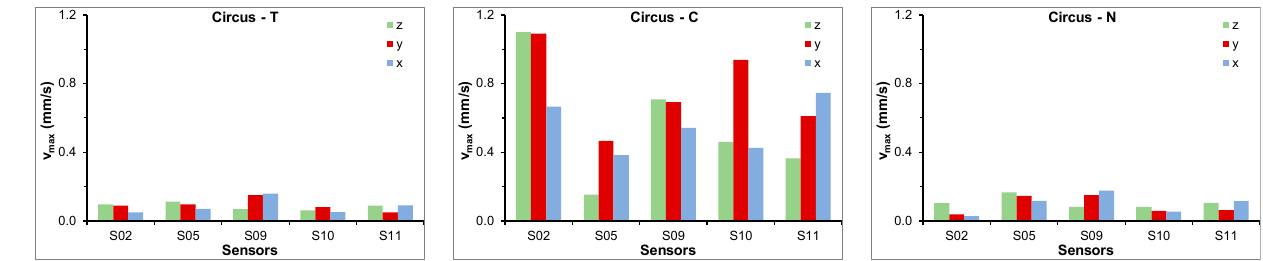
Figure 20. Circus: maximum velocity in the three time intervals.